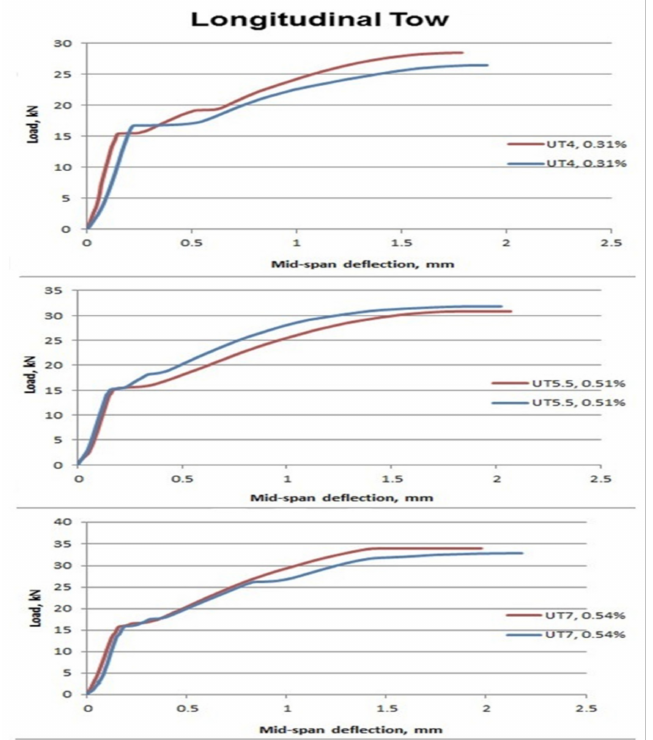
Figure 16. Mid-span load-deflection of uni-axial tows with various fibre volume